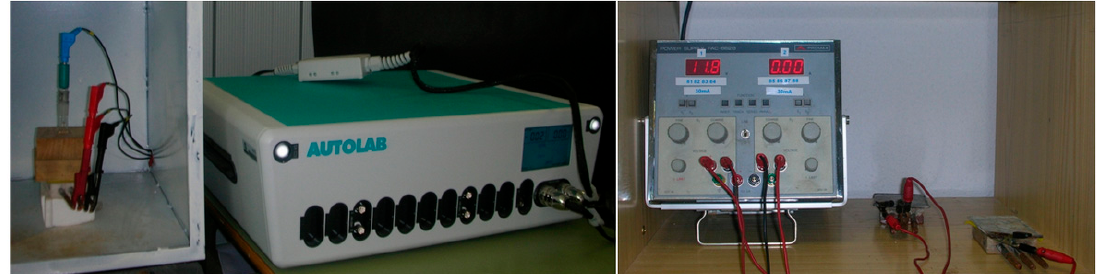
Figure 2. Setup for carrying out electrochemical measurements using an AUTOLAB/PGSTAT302N potentiostat and setup of the accelerated corrosion process using a POWER SUPPLY FAC-662B (PROMAX, Barcelona, Spain, 1998).